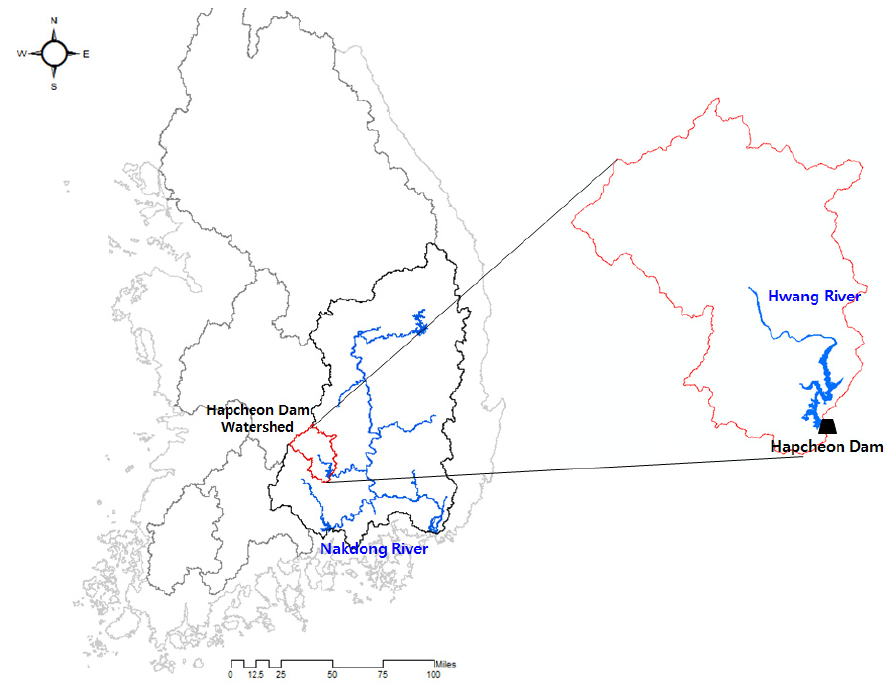
Figure 1. Location of Target Watershed in the Hapcheon Dam. Table 1. Storage Information of Hapcheon Dam